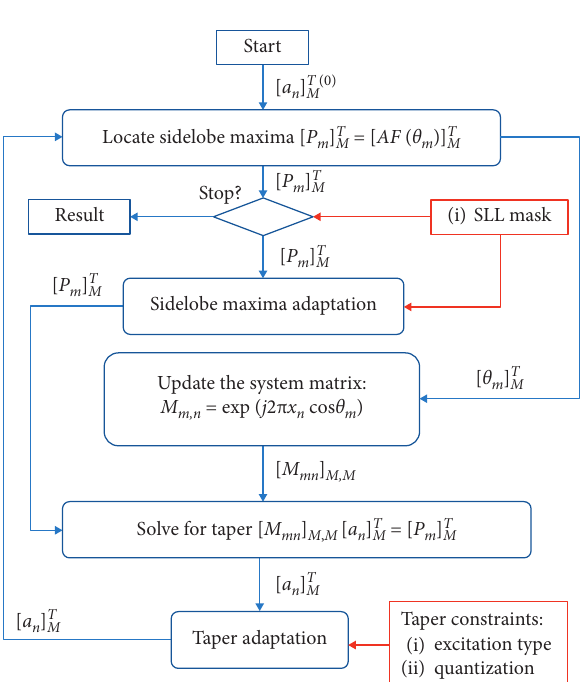
Figure 5: Block diagram of the linear array pattern synthesis technique detailed in Refs. [41, 42].